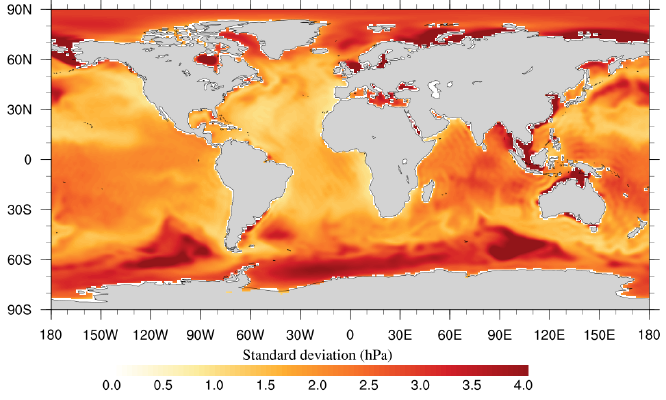
Figure 8. Standard deviation of mass anomalies expressed as ocean bottom pressure equivalent derived from the European Gravity Service for Improved Emergency Management (EGSIEM) combined